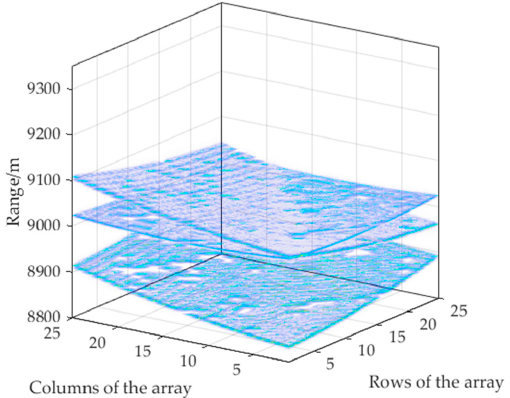
Figure 18. The range profile in 3D space of sparse array. Figure 7. The range profile in 3D space of sparse array. The echo of a single target can also be obtained by 3D Hough transform, and the Figure 7. The range profile in 3D space of sparse array. separation result is shown in Figure 8. separation result is shown in Figure 8.